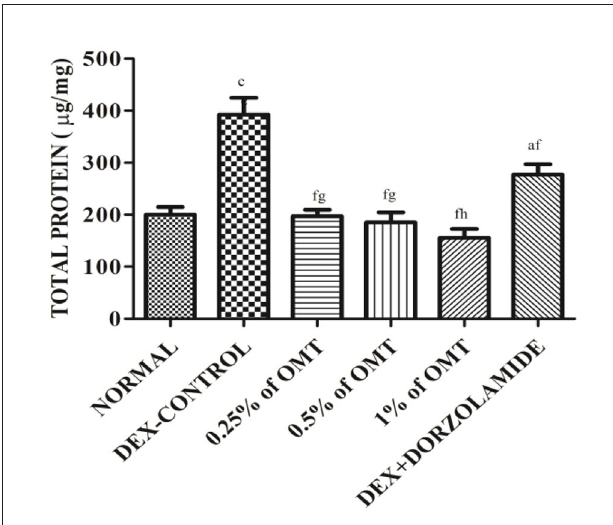
FIGURE 4 | Effects of various treatments on the retinal protein extracts. Values are expressed as mean ± SEM ( n = 6). Data were analyzed by one-way ANOVA and are expressed as a p < 0.05, b p < 0.01, c p < 0.001 when compared to normal group, d p < 0.05, e p < 0.01, f p < 0.001 when compared to DEX-induced glaucoma control group, and g p < 0.05, h p < 0.01, i p < 0.001 when compared to standard group, respectively. Normal: 100 µ l of distilled water; control: 0.1ml of 0.1% DEX solution; treatment 1: 50 µ l of 0.25% OMT solution; treatment 2: 50 µ l of 0.5% OMT solution; treatment 3: 50 µ l of 1% OMT solution; standard: 100 µ l of 1% of dorzolamide solution.